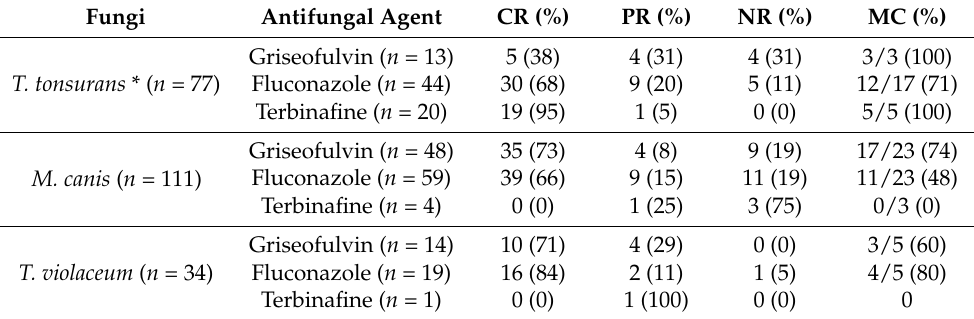
Table 4. Patients’ response per fungi to the respective oral regimen.